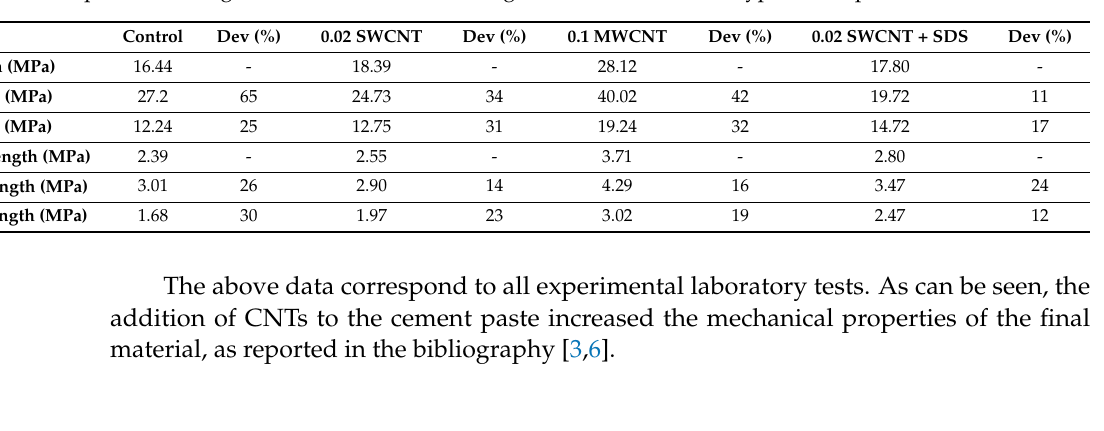
Figure 5. ( left ) Compressive strength average value with deviation bars; ( right ) indirect tensile strength average value with deviation bars for control cement and each type of composite. Table 3. Compressive strength and indirect tensile strength test results for each type of composite.